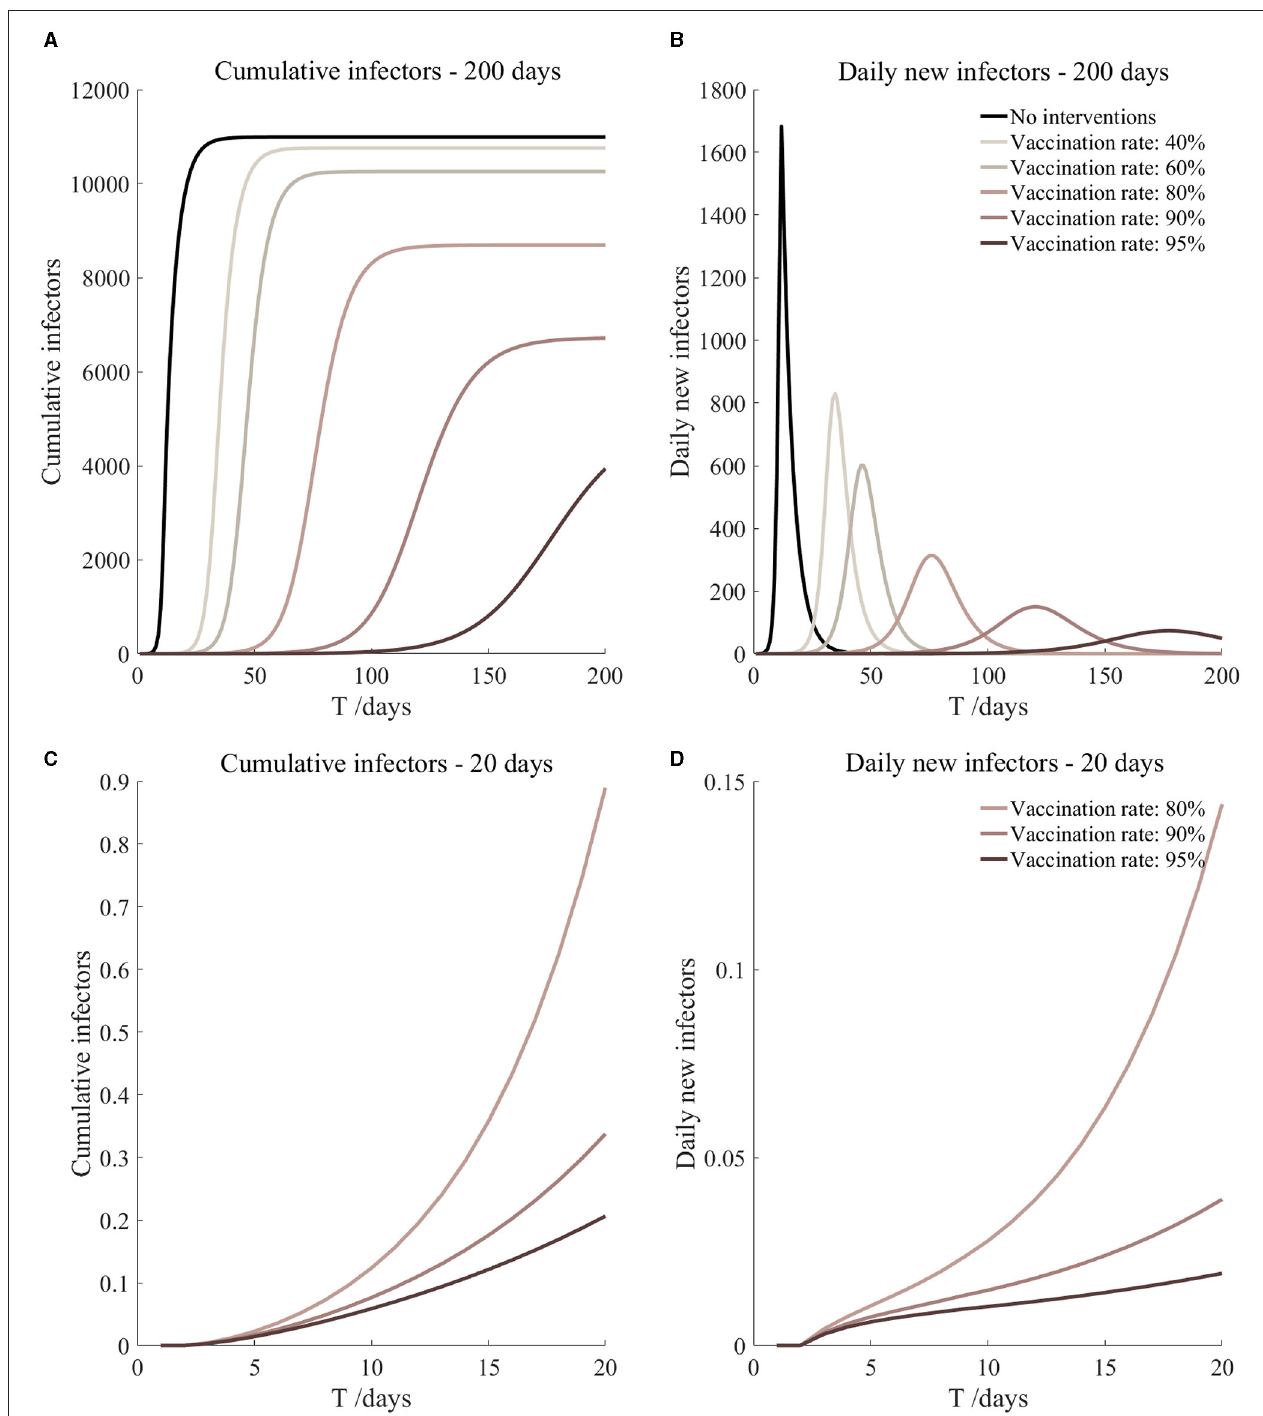
FIGURE 9 | Vaccination and 14-day compulsory quarantine. Assume pre-flight screening can identify 20% of asymptomatic infectors, 14-day compulsory quarantine has about a 4% risk of missed detection.